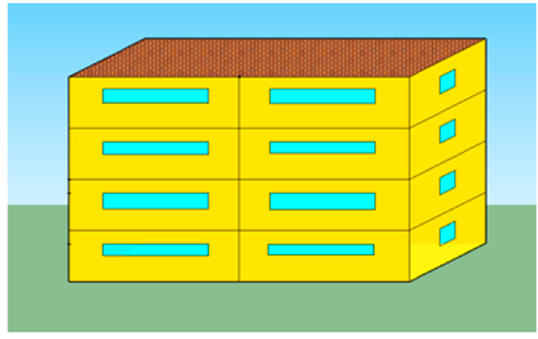
Figure 1. Single building representation in the SKETCHUP [79] environment. Table 2. Building envelope and geometric parameters.